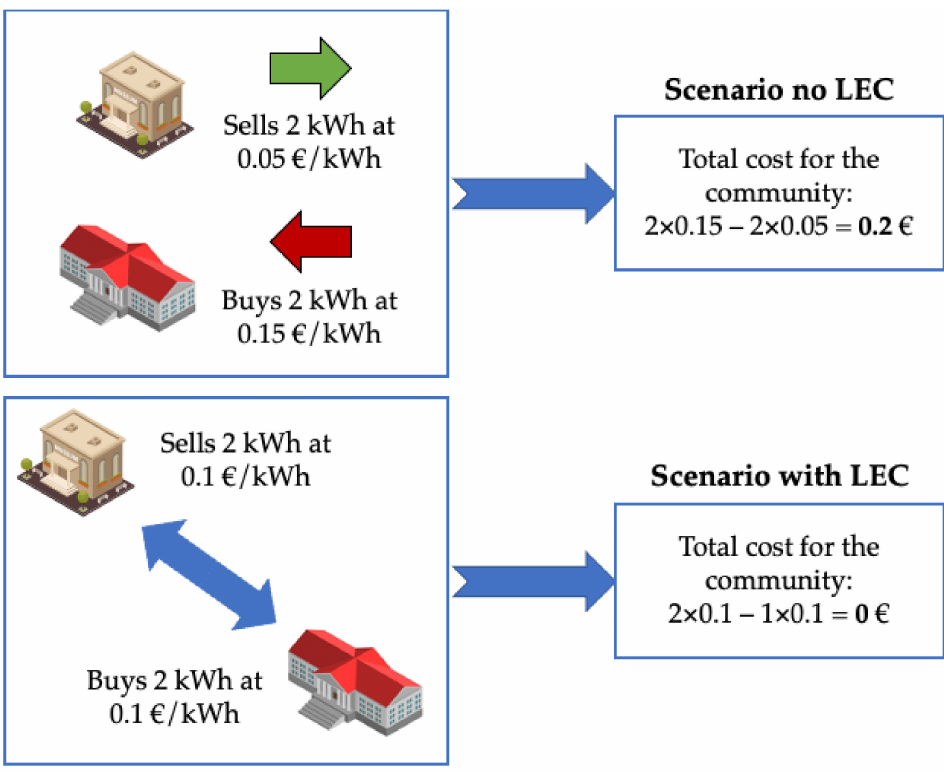
Figure 5. An example of energy buy and sell prices into a LEC, compared with buying and selling energy to the main